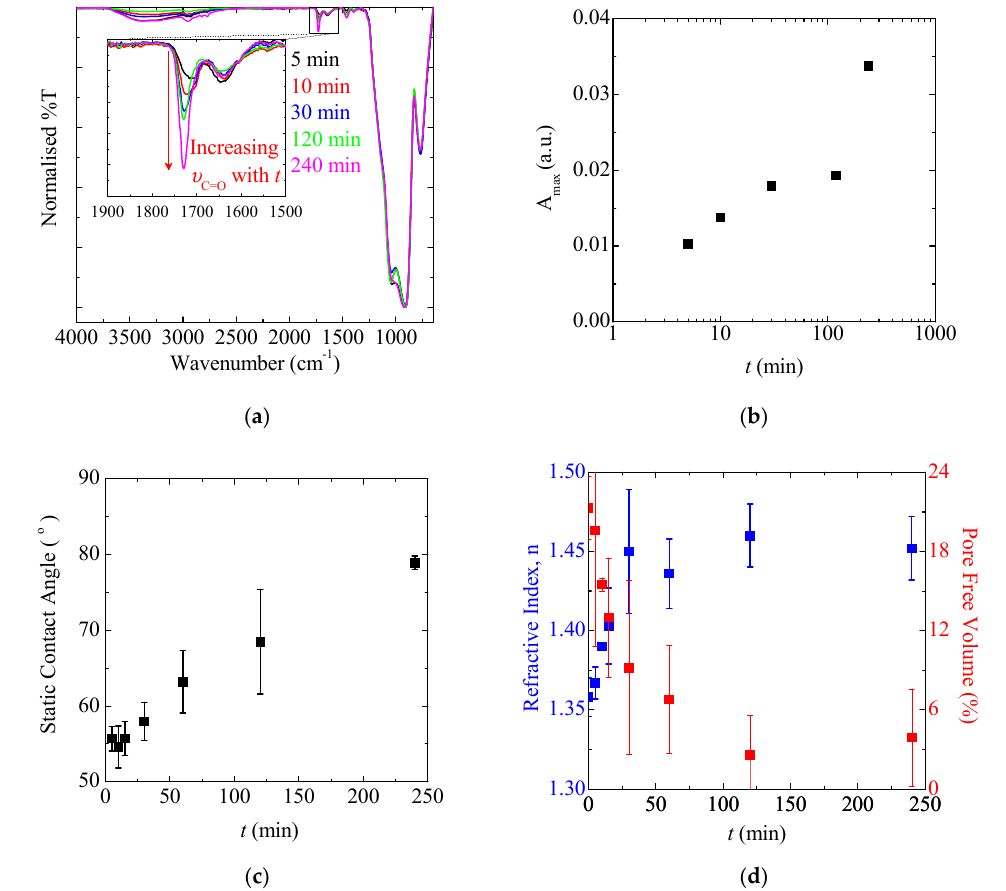
Figure 6. Polymerisation kinetics under confinement: ( a ) IR spectra; ( b ) corresponding C=O stretching absorbance associated with grafted PDMAEMA; ( c ) static CA measurements; and ( d ) refractive index ( ■ ) and corresponding free volume ( ■ ) from ellipsometry. Reaction conditions: DMAEMA:DMF = 1:8 ( v / v ), 0–240 min, SIP confined to pores by pre-treating the 5SBDCSi films with a CO 2 plasma.